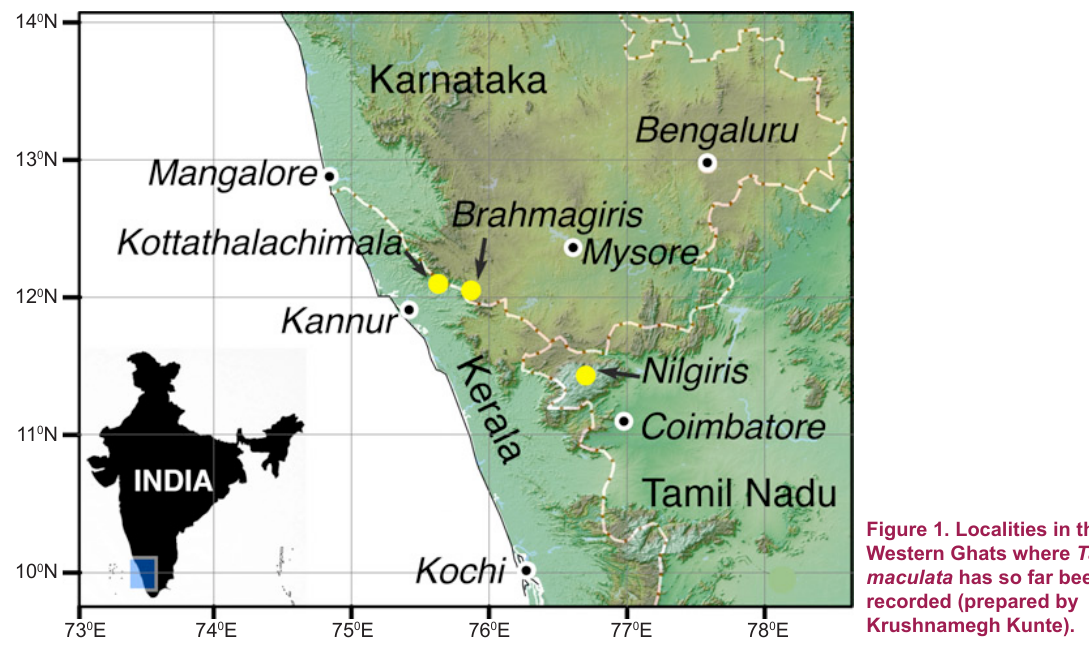
Figure 1. Localities in the Western Ghats where Tajuria maculata has so far been recorded (prepared by Krushnamegh